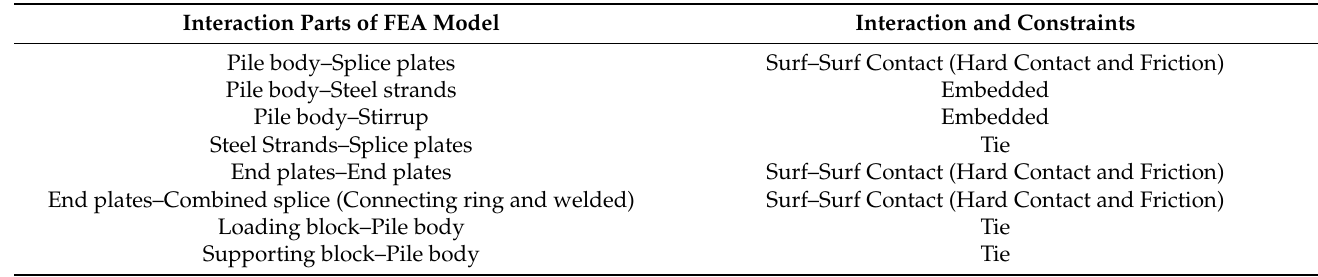
Table 8. Interaction and Constraints.